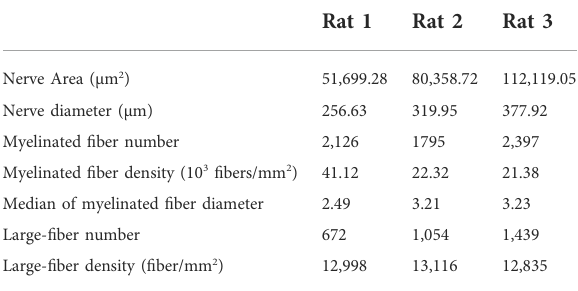
TABLE 1 Morphometric parameters of the segments of the vagus nerve in three